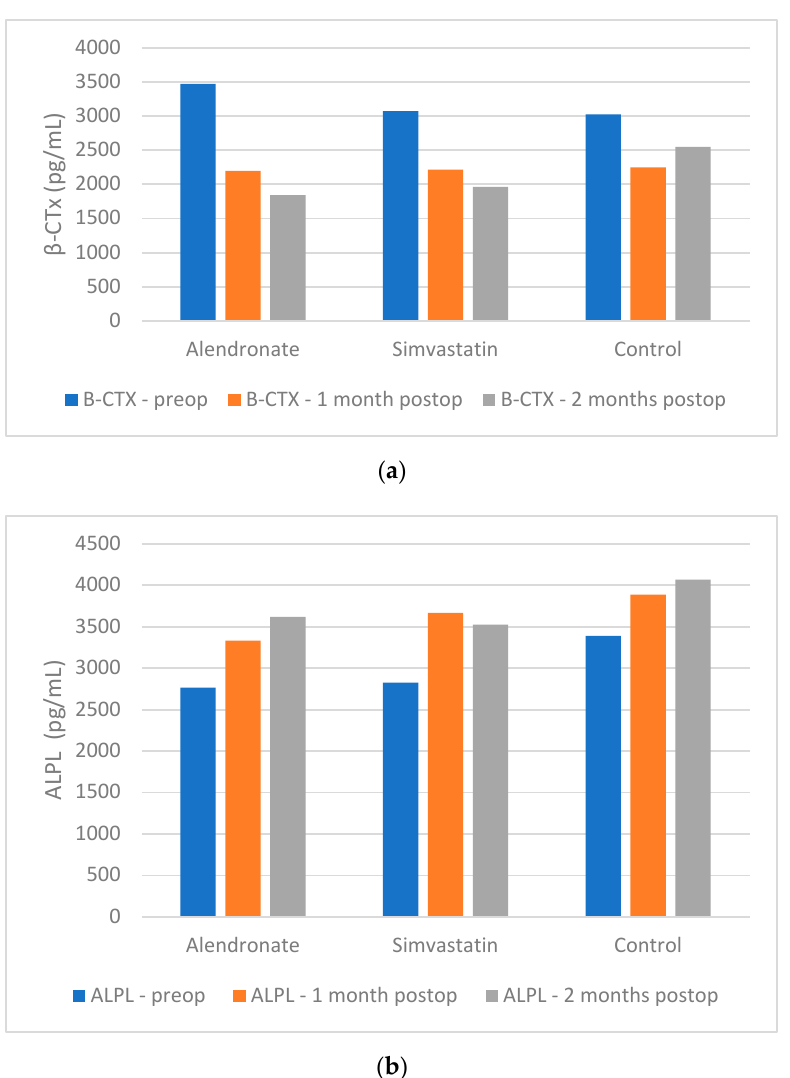
Figure 6. β -CTx ( a ) and ALPL ( b ) levels within groups at preoperatively, one month postoperatively, and two months postoperatively.